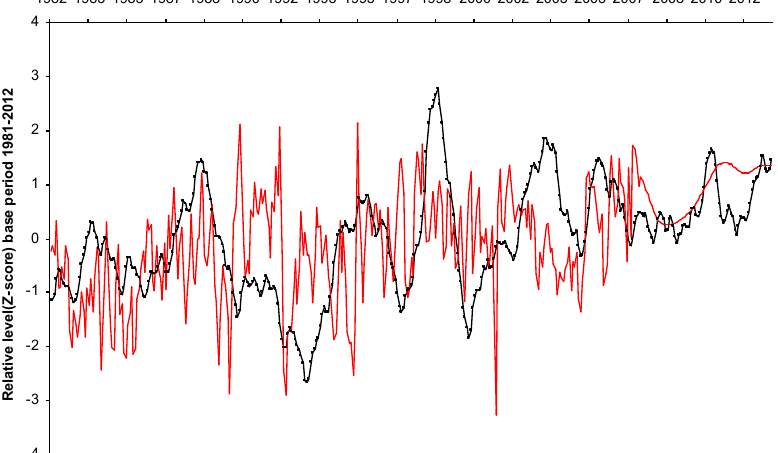
Figure 11. Z -scored monthly data: NDVI (black curve) compared to the difference between the temperature projected from an IPCC mid- range scenario model (CMIP3, SRESA1B scenario) run for the IPPC fourth assessment report (IPCC, 2007) and global surface temperature (red dotted curve). Table 13. Order of integration test results for NDVI series for monthly data from 1981–2012. The Schwartz information criterion (SIC) was used to select an optimal maximum lag length in the tests. NDVI series Null hypothesis: the series has a unit root Probability of unit root